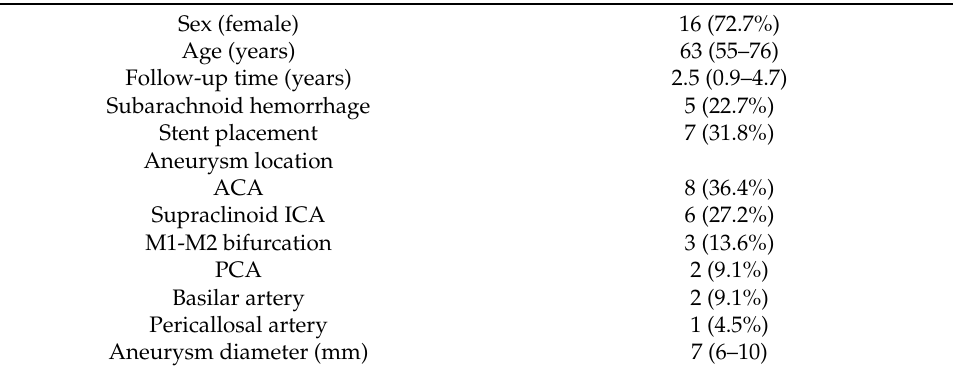
Table 1. Demographic, clinical and procedure